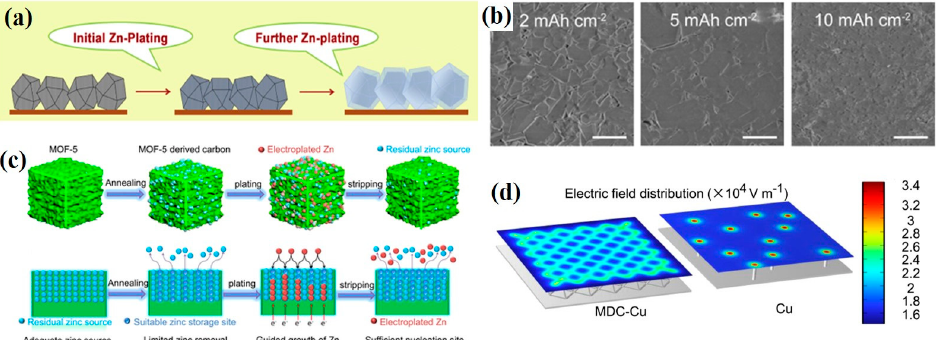
Figure 7. ( a ) Schematic illustration of the Zn plating on ZIF-8-500 electrode. ( b ) SEM images of Zn deposits at 1.0 mA cm − 2 for di ff erent capacities. ( c ) Schematic diagram of the electroplating/stripping principle of MDC. ( d ) Simulation of the electric fi eld distribution of MDC–Cu and a planar bare Cu